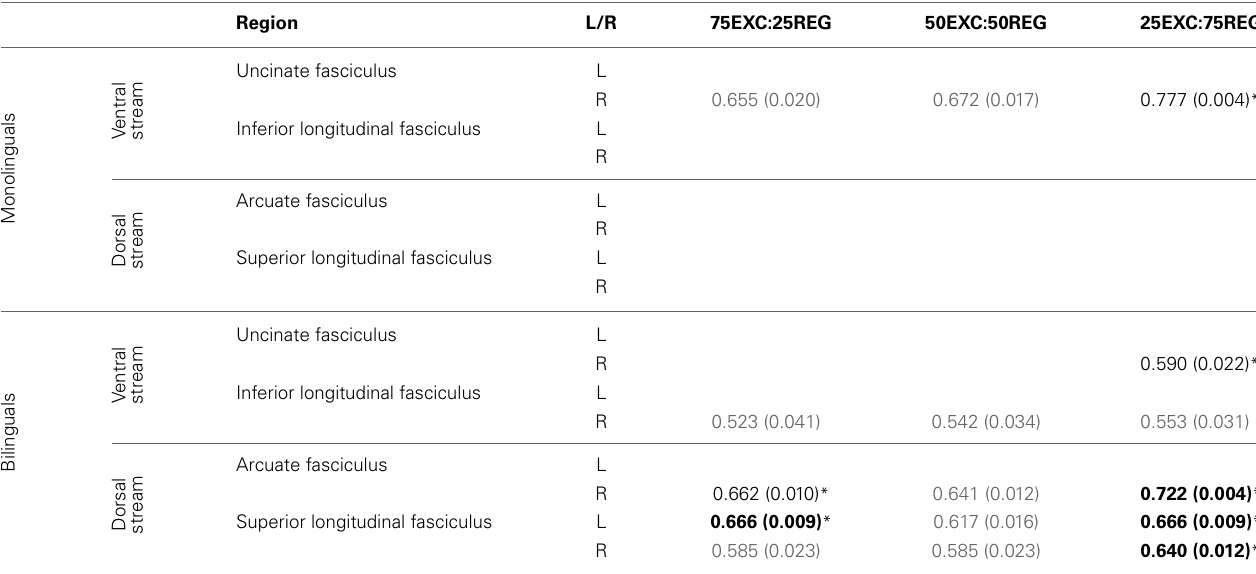
Table 2 | Pearson’s r -value ( p- value) for correlation between MD values and RT in monolingual and bilingual